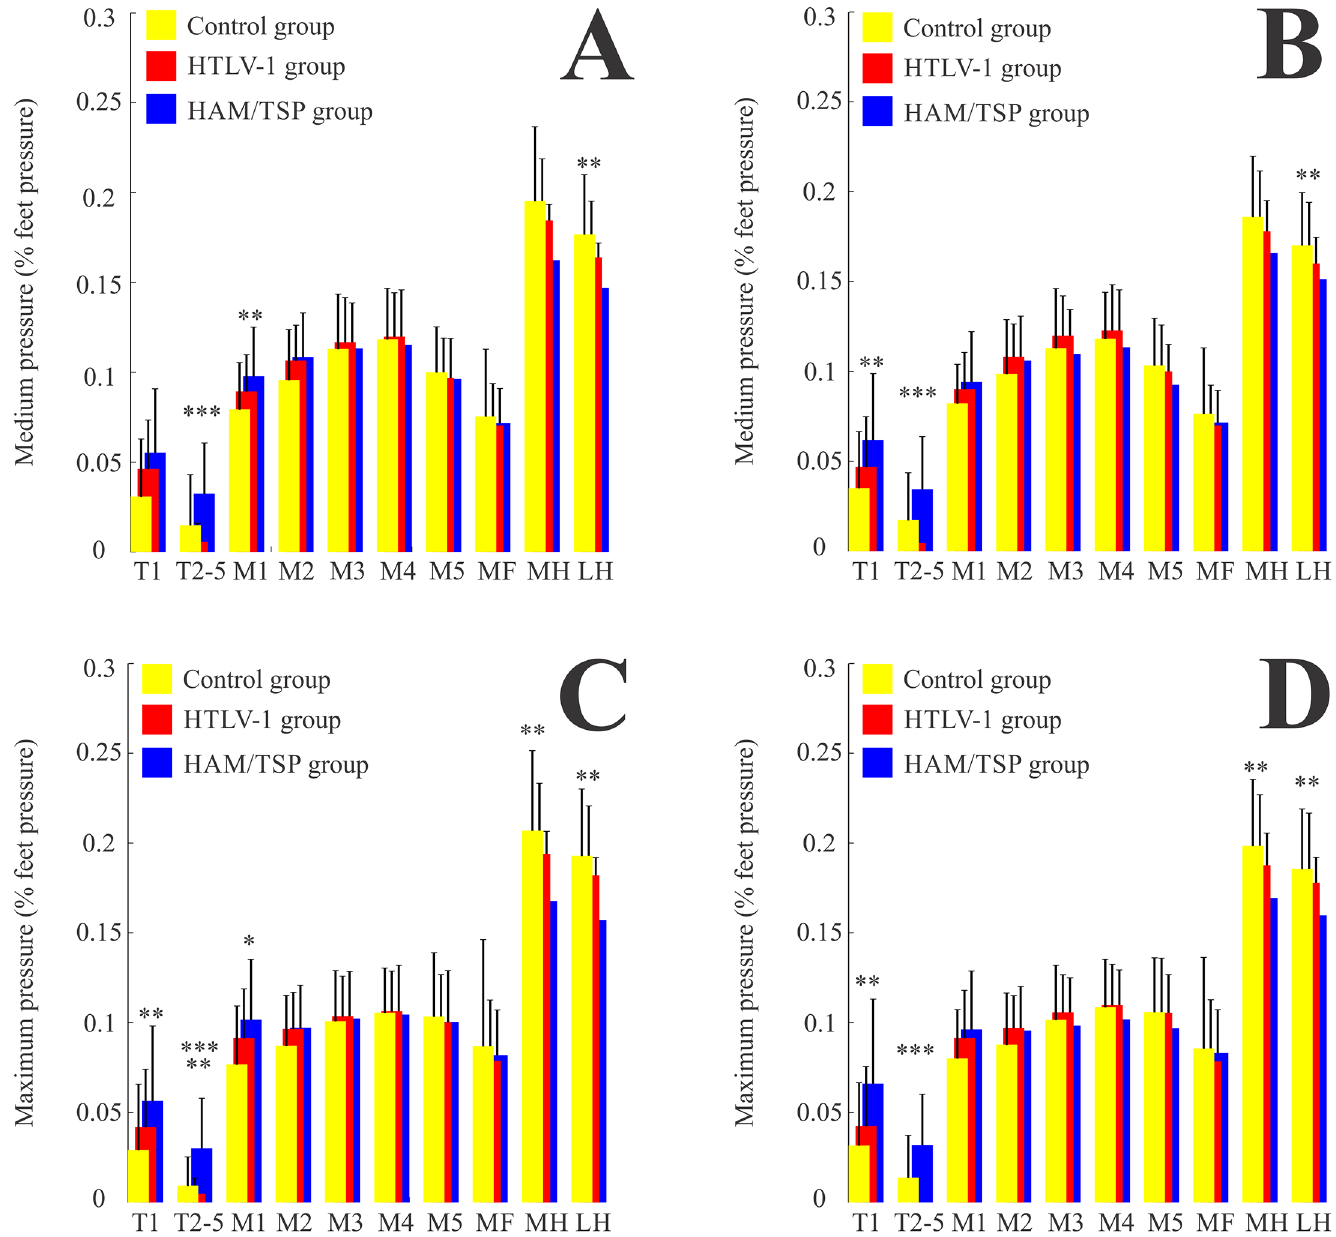
Fig 1. Plantar pressure distribution. Means and standard deviations of the medium (A and B) and maximum (C and D) pressure values obtained in the open eyes (A and C) and closed eyes (B and D) conditions in the three groups (control, yellow; HTLV-1, red; and HAM/TSP, blue). * p < 0.001 compared to both control and HTLV-1, ** p < 0.001 compared to control, and *** p < 0.001 compared to